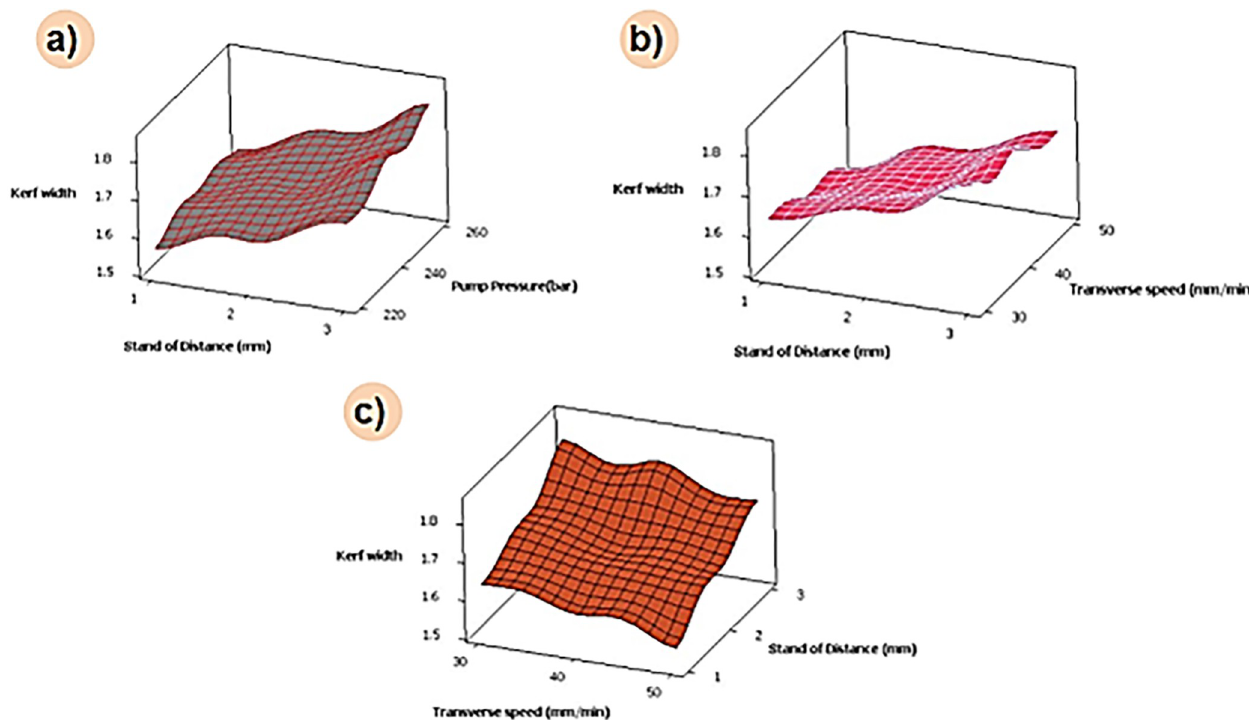
Fig 13. Influence of AWJM parameters on kerf width for 0.3 wt. % of filler loaded composite.